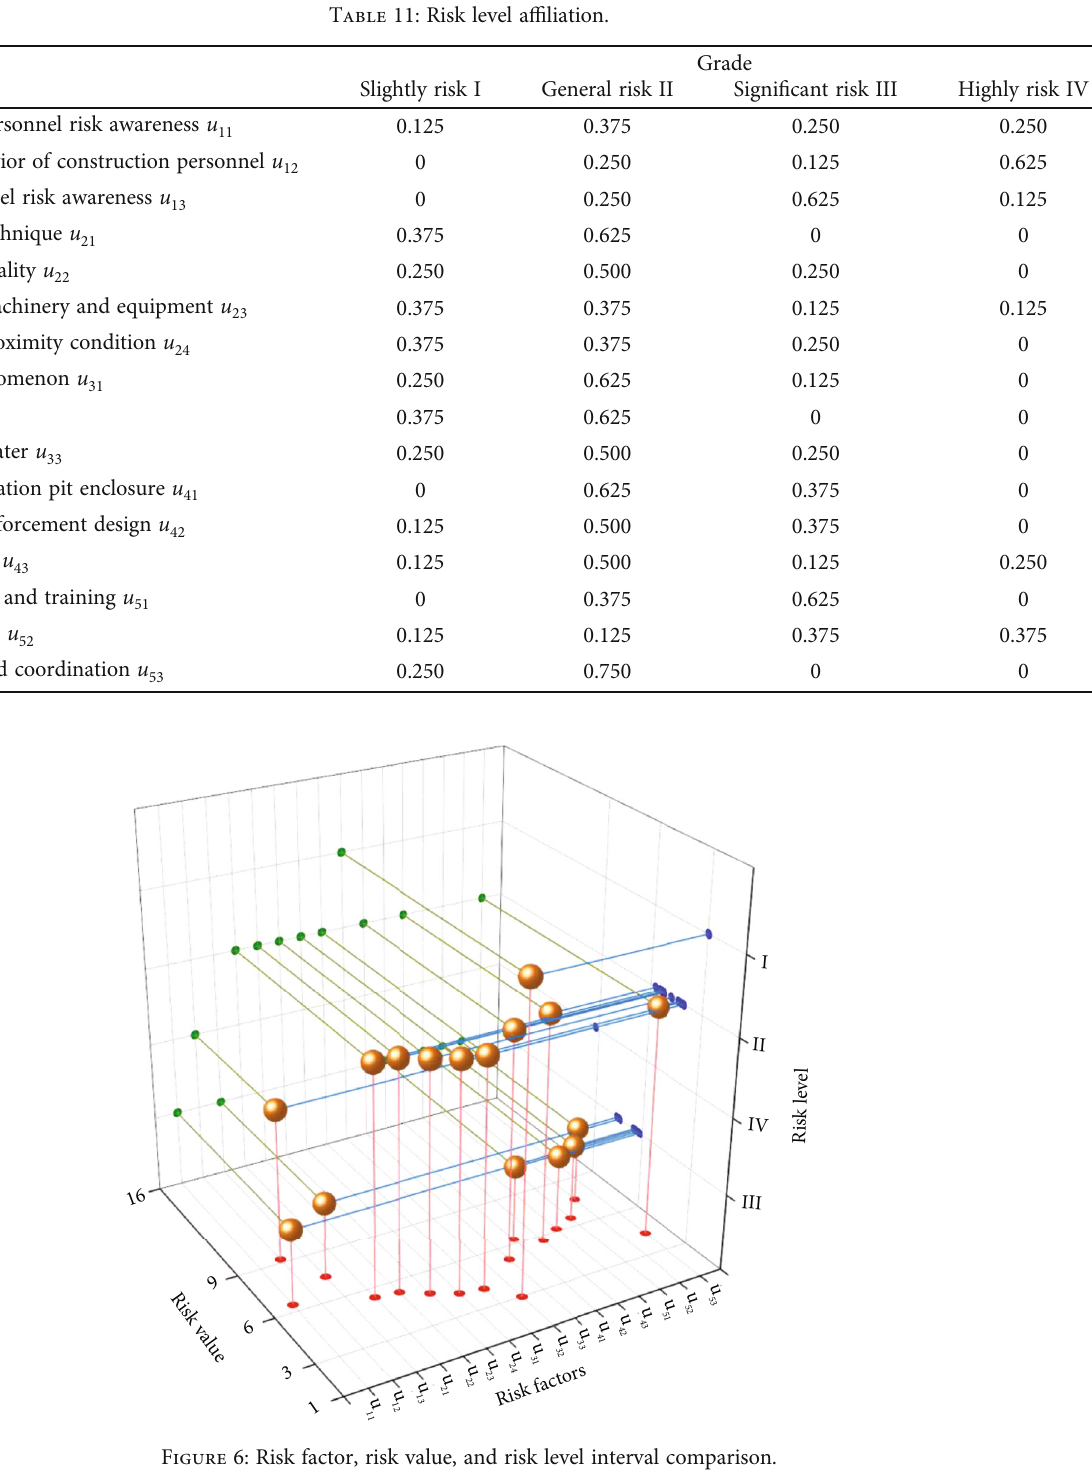
Figure 6: Risk factor, risk value, and risk level interval